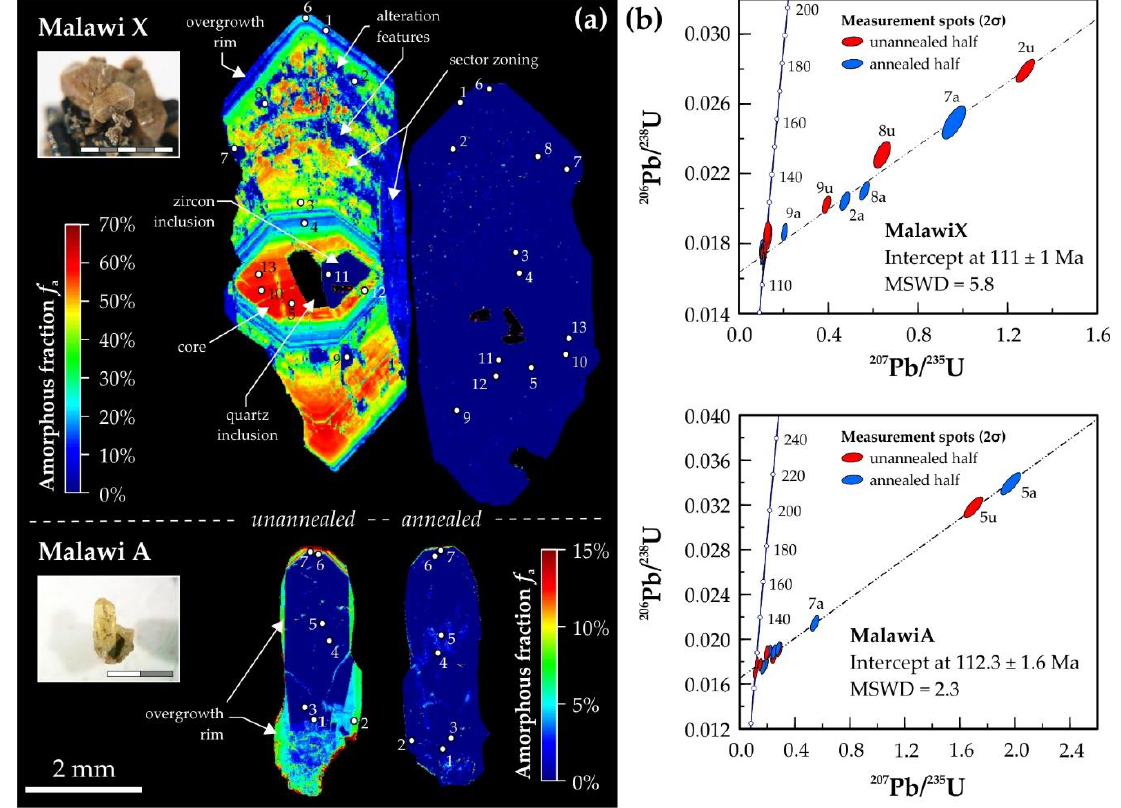
Figure 7. ( a ) PL hyperspectral maps of two zircon crystals from pegmatites of the Mt. Malosa massif, Malawi (see inset photographs) that were cut in half, with one half annealed at 1300 °C for three days (cf., Figure 4). The amorphous fraction f a determined according to the deconvolution procedure of the Dy 3+ photoluminescence as described above is given colour-coded. Note, that the scale may vary, e.g., to highlight subtle differences in radiation damage accumulation within sample MalawiA. Spots of LA-ICP-MS, detailed Raman and PL measurements are indicated. ( b ) U-Pb concordia and results of LA-ICP-MS isotope ratios obtained from measurement spots indicated in ( a ).